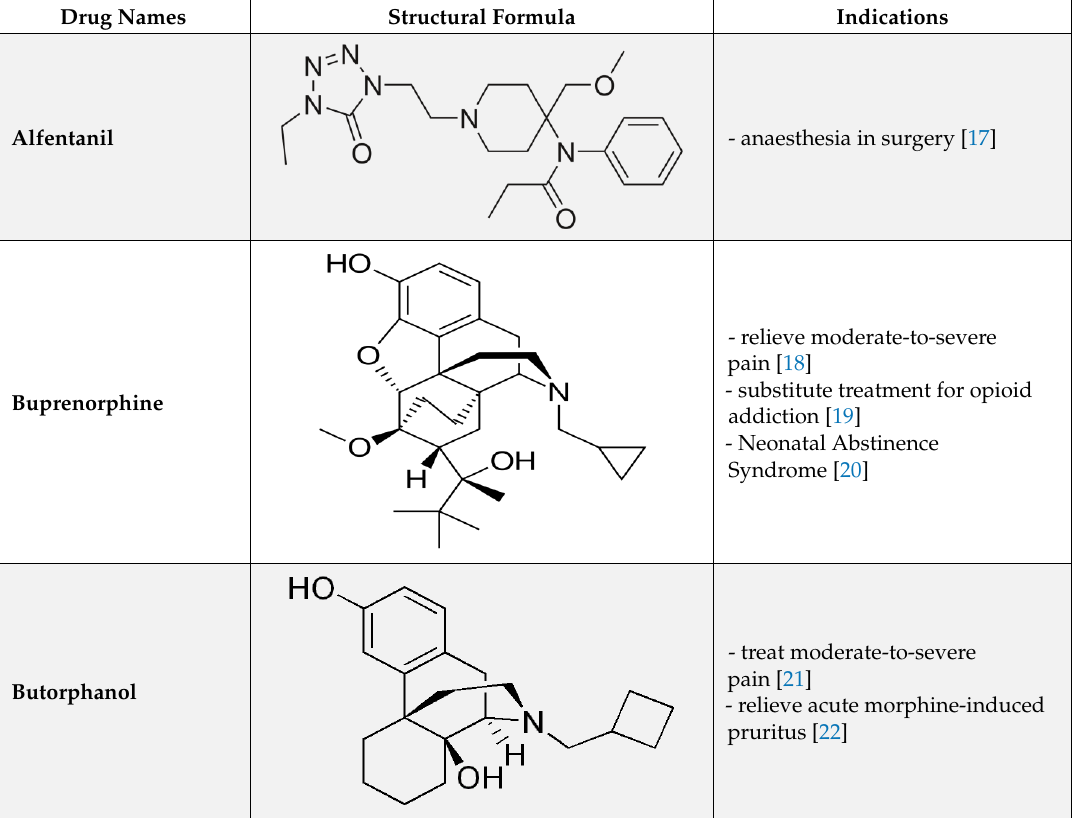
Table 1. Agonists of µ receptors which are useful in clinical practices.